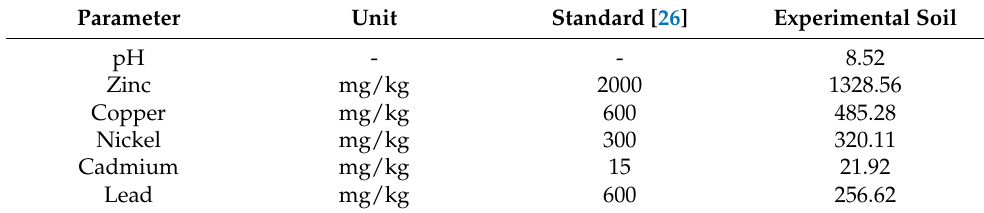
Table 3. The chemical analysis for PTE in experimental